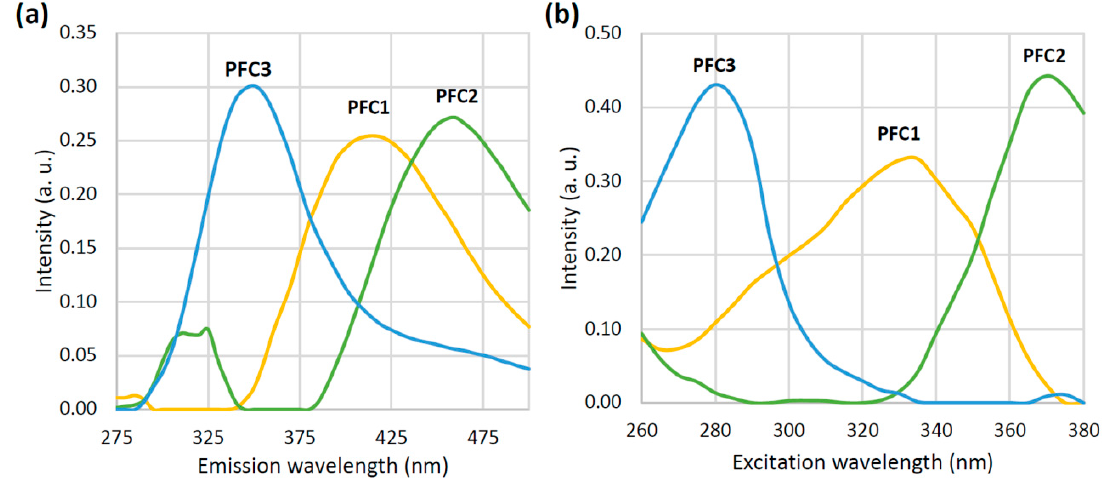
Figure 2. Emission ( a ) and excitation ( b ) loading vectors for the three PARAFAC components (PFC1–PFC3).